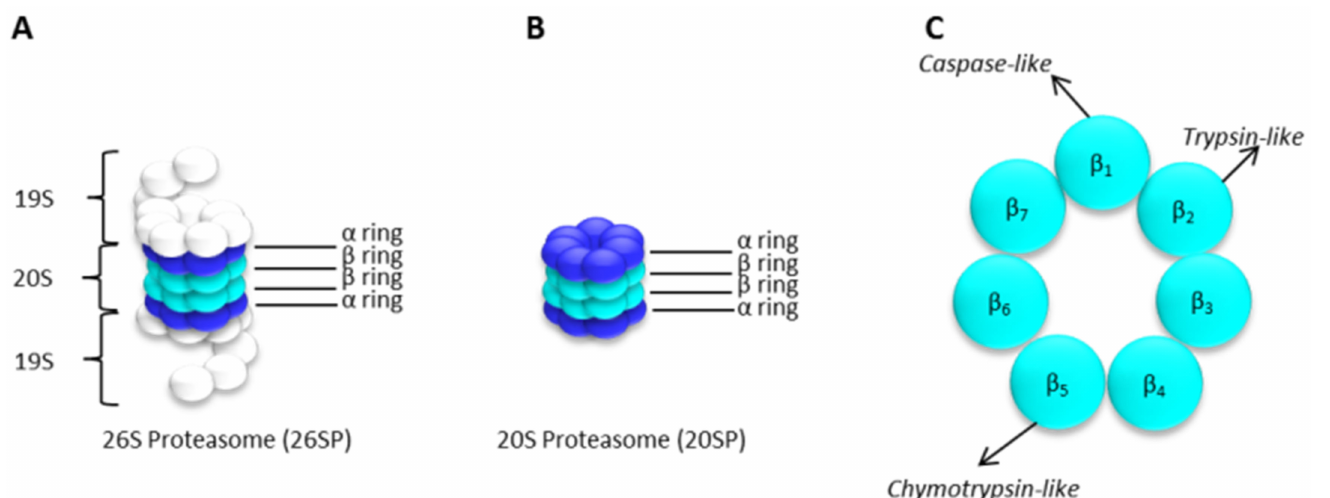
Figure 4. ( A ) 26S proteasome. The 26S proteasome consists of a multimeric protease with 2 19S RP and the 20S CP. ( B ) The 20S CP is constituted by 2 α heptameric rings and 2 β heptameric rings. ( C ) The catalytic subunits are located in 3 distinct β subunits, in both β heptameric rings. The 19S RP is a 700 kDa ring-shaped complex also called proteasome activator 700 (PA700) and is formed by two substructures, a lid and a base, with multiple subunits, as shown in Figure 4A. The 19S RP recognizes polyubiquitinated proteins and promotes either their ATP-dependent unfolding or the dismantling of ubiquitin chains, catalyzed by proteasome-associated DUBs [2]. The 20S CP generally mediates the cleavage/degradation of polyubiquitinated protein substrates that have been unfolded by the 19S RP into small peptides and amino acids [2,22]. However, in some cases, the 20S CP can act alone through ubiquitin-independent degradation pathways, still being functional towards certain pro- teins